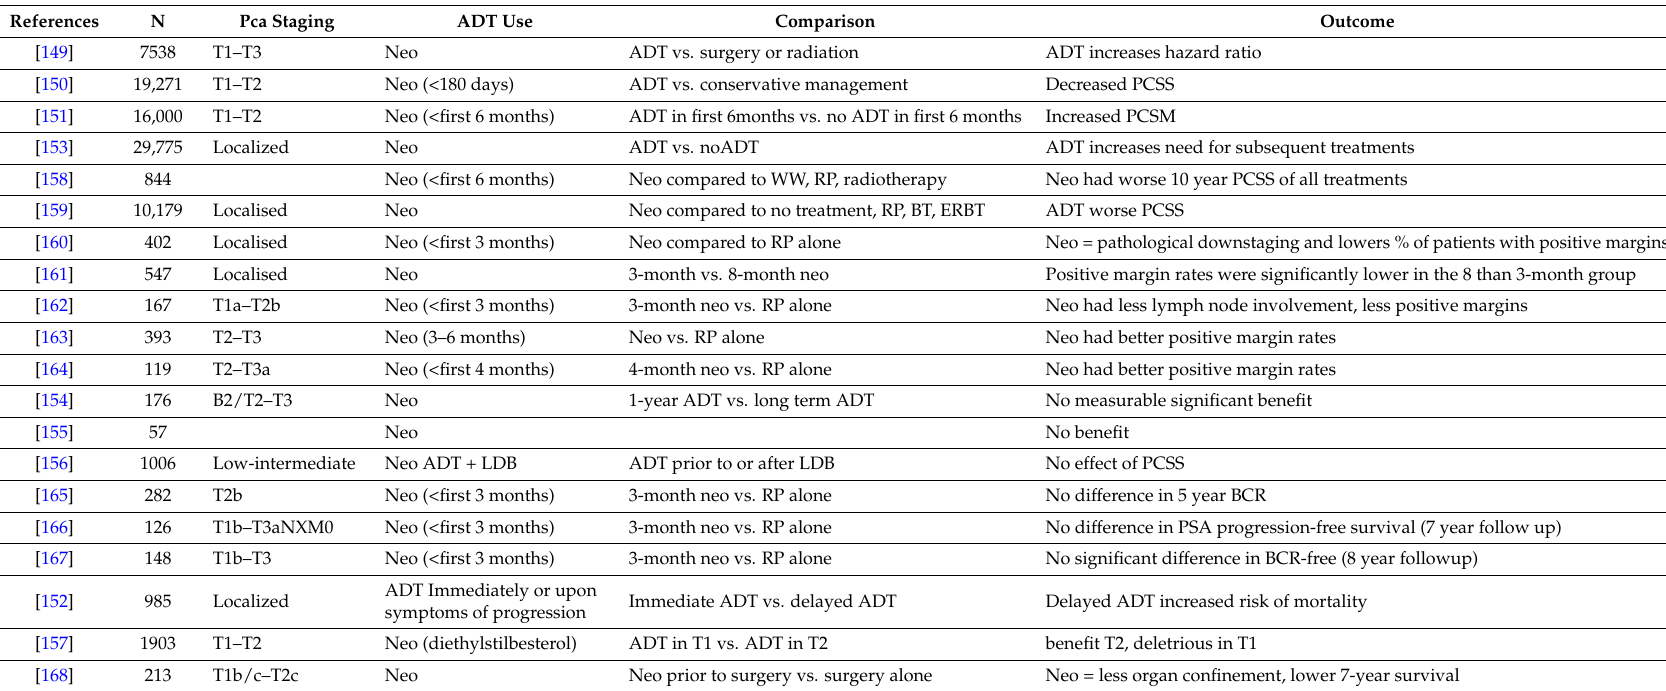
Table 4. Outcomes from studies investigating effects of neoadjuvant ADT and outcomes of patients with localized prostate